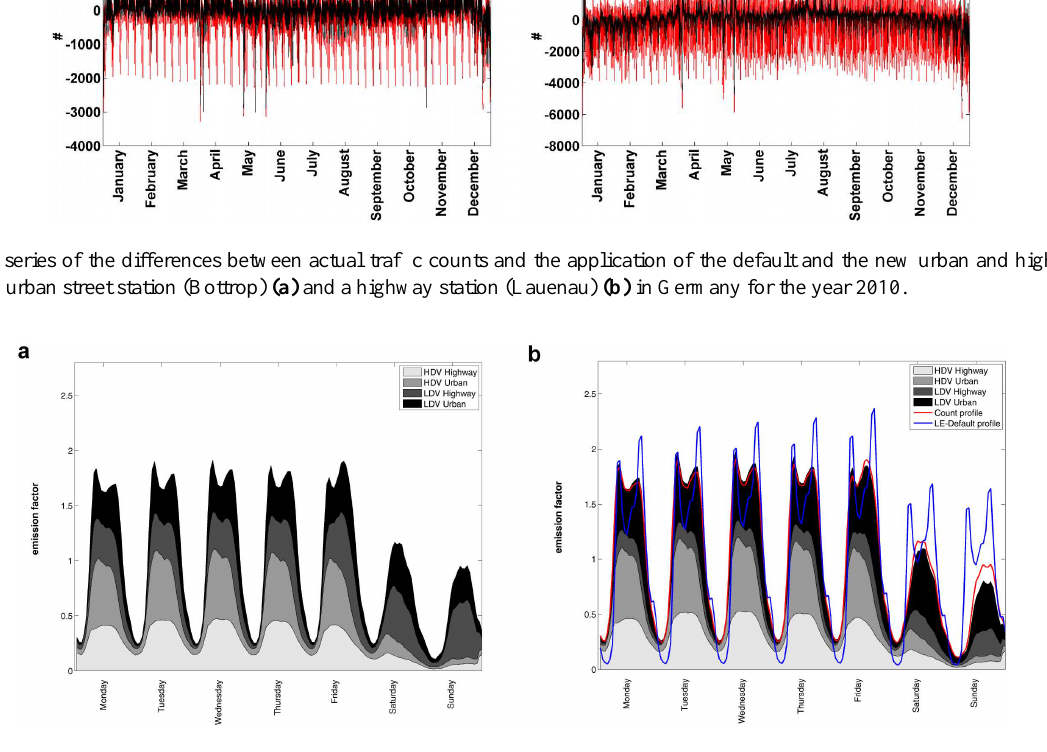
Fig. 3. Summation of diurnal cycles per day of the week for LDV and HDV on urban streets and highways equally weighted (a) and weighted with the NO x split factors (b) . The red line (count profile) in (b) is the same as the black line in (a) ; the blue line represents the default time